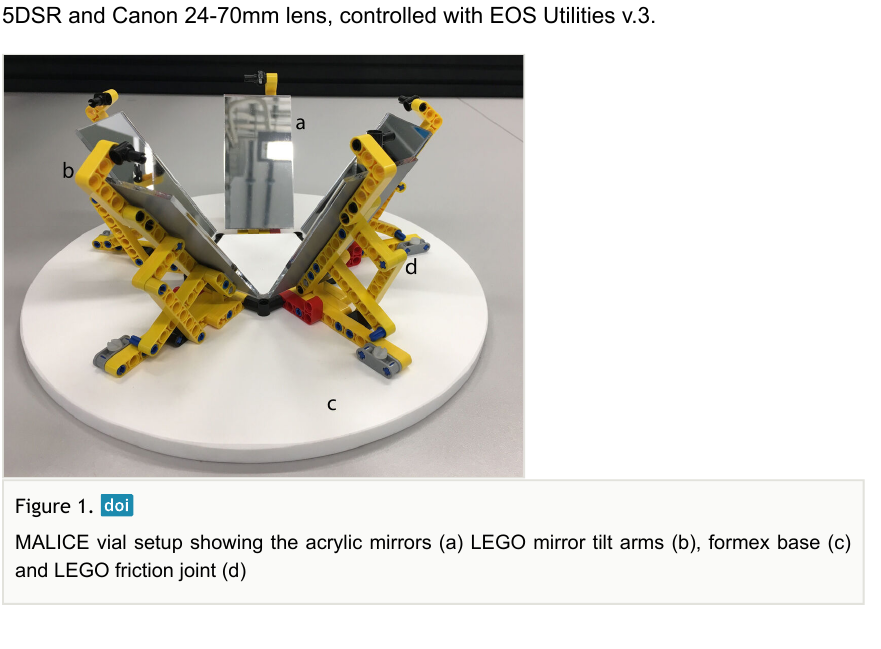
mirror tilt to accomdate different vial sizes. Mirror tilt is achieved using a friction joint (Fig.